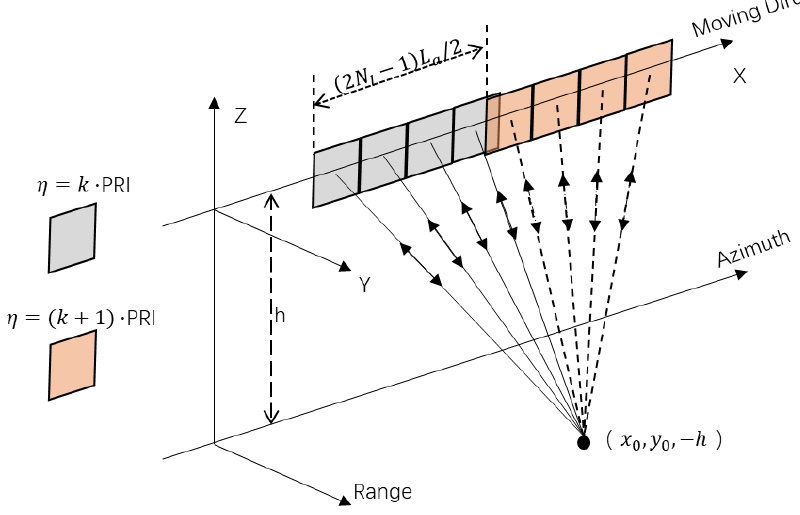
Figure 1. Geometry of multiple-input multiple-output synthetic aperture radar (MIMO-SAR).